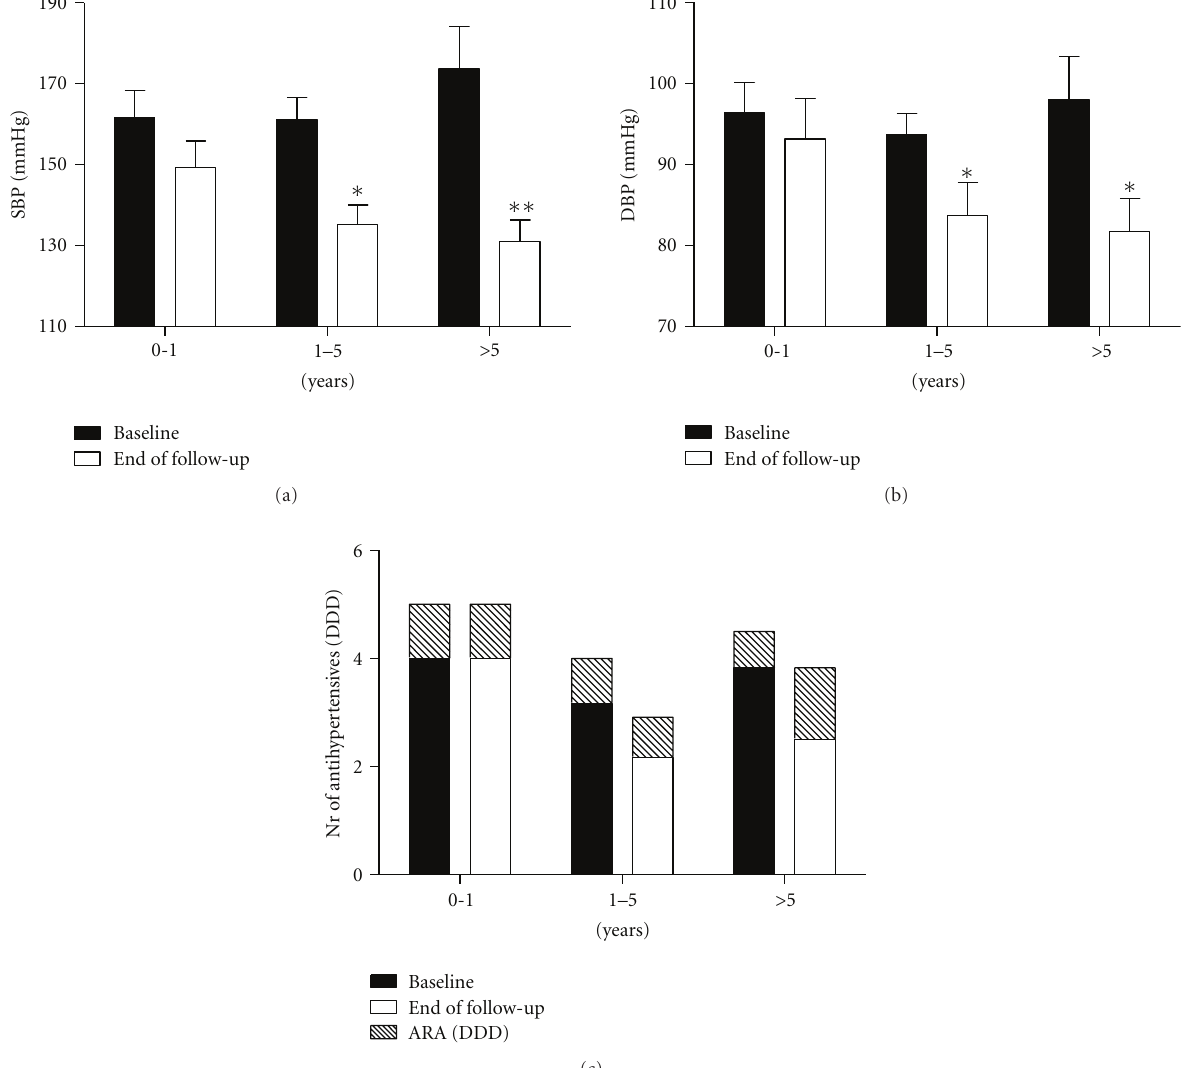
are more likely to receive ARA treatment for a longer